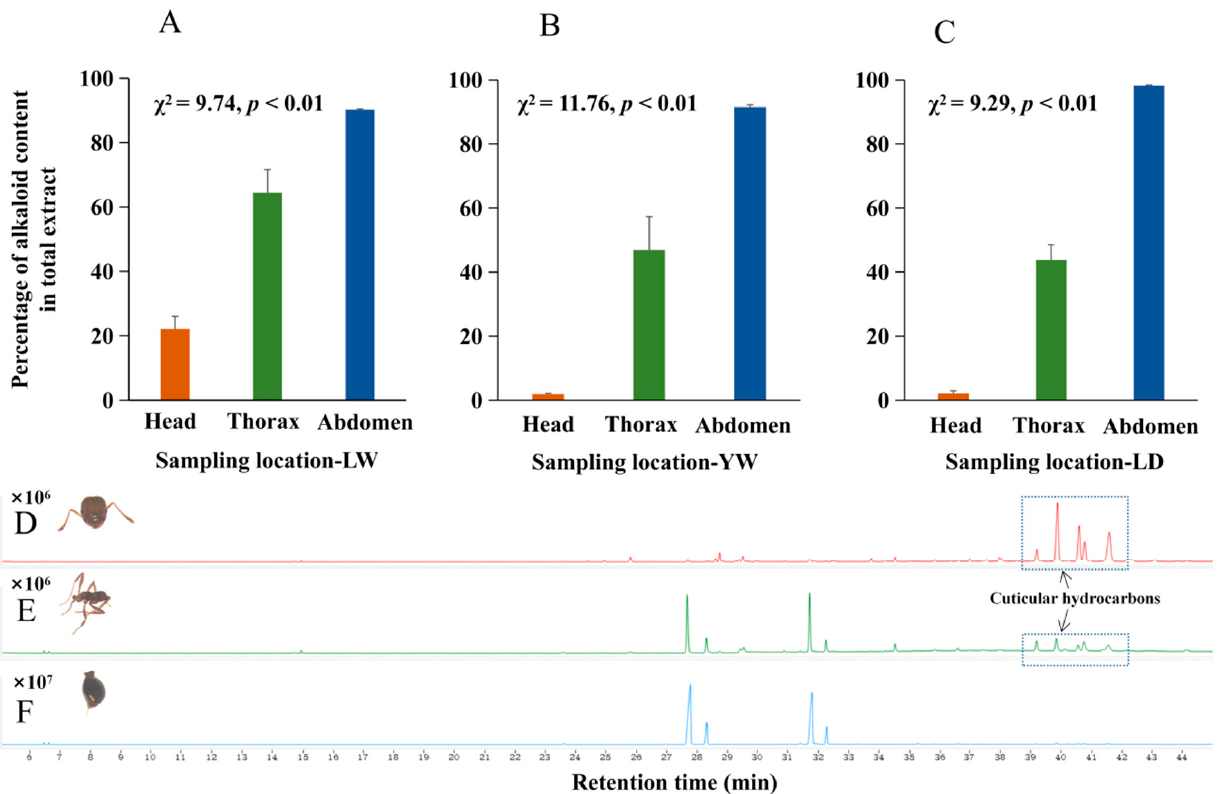
Figure 2. The alkaloid contents in different body parts of the S. invicta body relative to that in the total extract obtained from parts. Alkaloid content (( A ), sampling location was Longwan; ( B ), sampling location was Yiwu; ( C ), sampling location was Liandu) and alkaloid ion chromatogram of the head (( D ), red line), thorax (( E ), green line) and abdomen (( F ), blue line) part of S. invicta body. All multiple comparisons were performed using Chi-square tests. Values are the means (+SEs) of triplicate experiments.